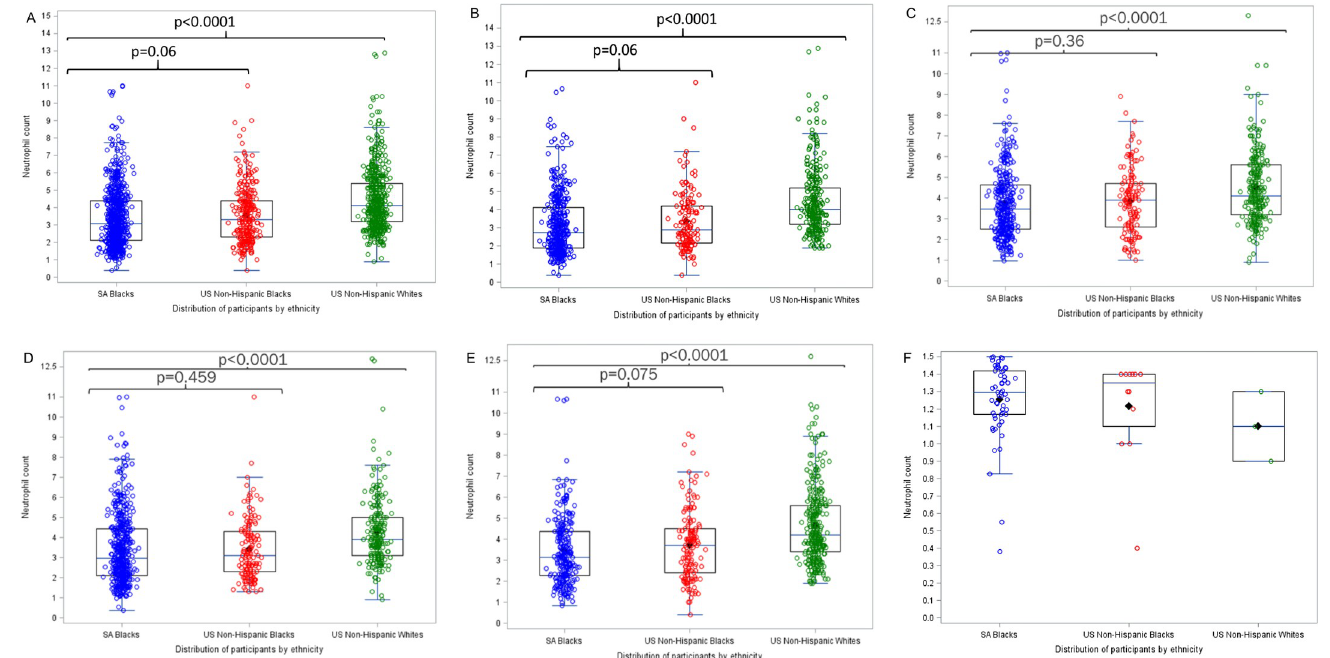
Fig 3. Neutrophil counts between the South African and US cohorts by ethnicity. 3A) Neutrophil counts by ethnicity. 3B) Neutrophil counts among males, 3C) Neutrophil counts among females, 3D) Neutrophil counts among 18-24-year-olds, 3E) Neutrophil counts among � 25-year-olds, 3F) Neutrophil counts among those with